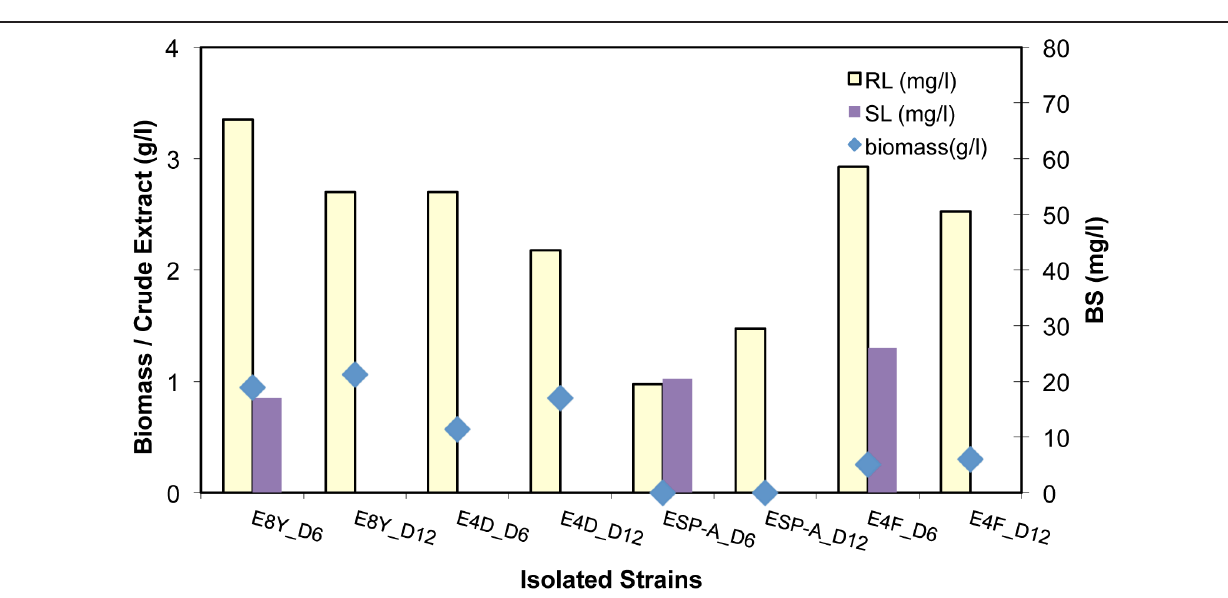
of 1744 cm − 1 . The asymmetrical stretching (VasCH2) and sym- metrical stretching (VasCH2) of methylene occurs at 2926–2930 and 2850–2860 cm − 1 , respectively. The stretch of C-O band of C (-O)-O-C in acetyl esters appears at 1247 cm − 1 (RL curve). The band at 1445 cm − 1 that corresponds to the C-O-H in plane bending of carboxylic acid (–COOH; Silverstein and Webster,